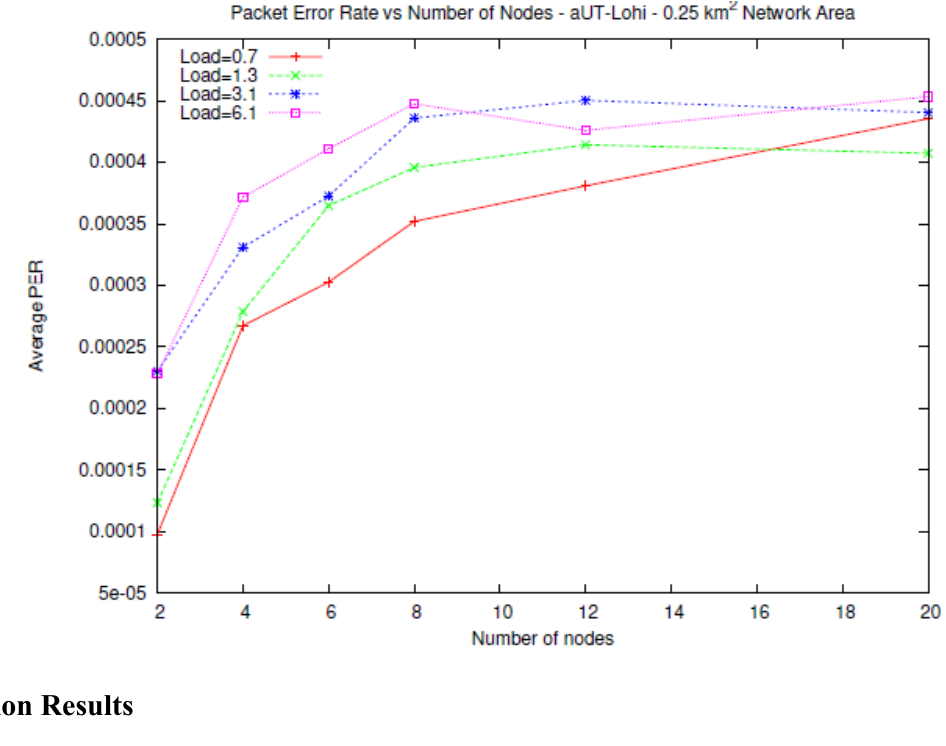
Figure 6. Average Packet Error Rate versus network size, for different offered